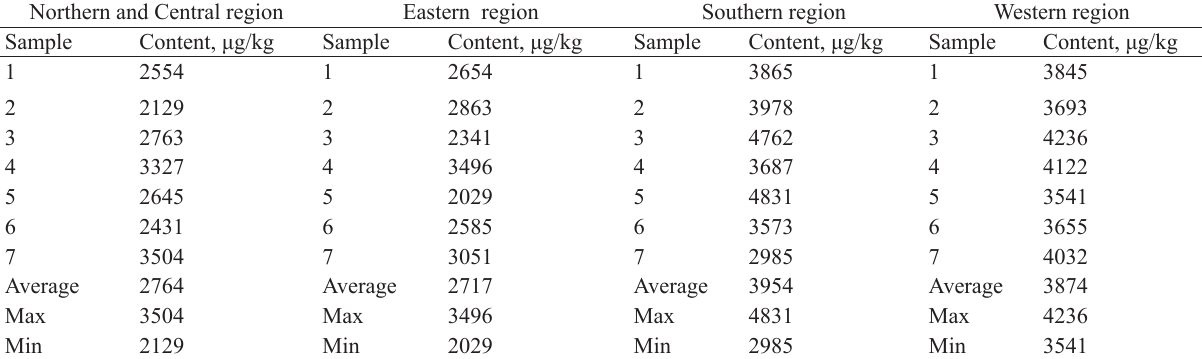
Table 6 Iron contents in raw milk samples Northern and Central region Eastern region Southern region Western